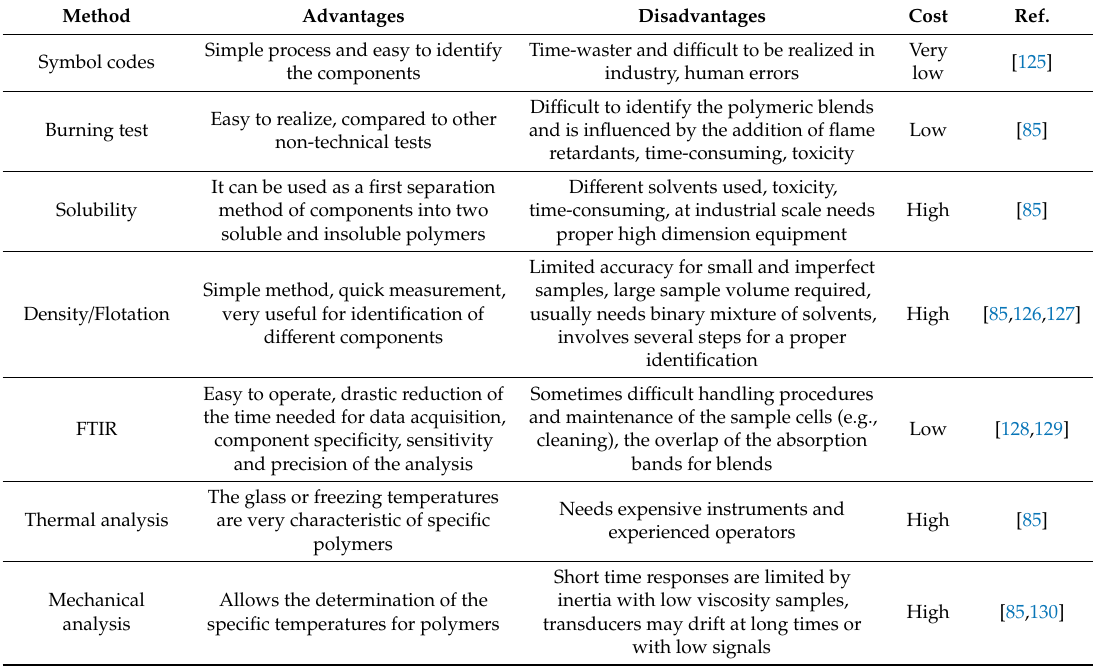
Table 7. Main characteristics of the methods used in WEEE